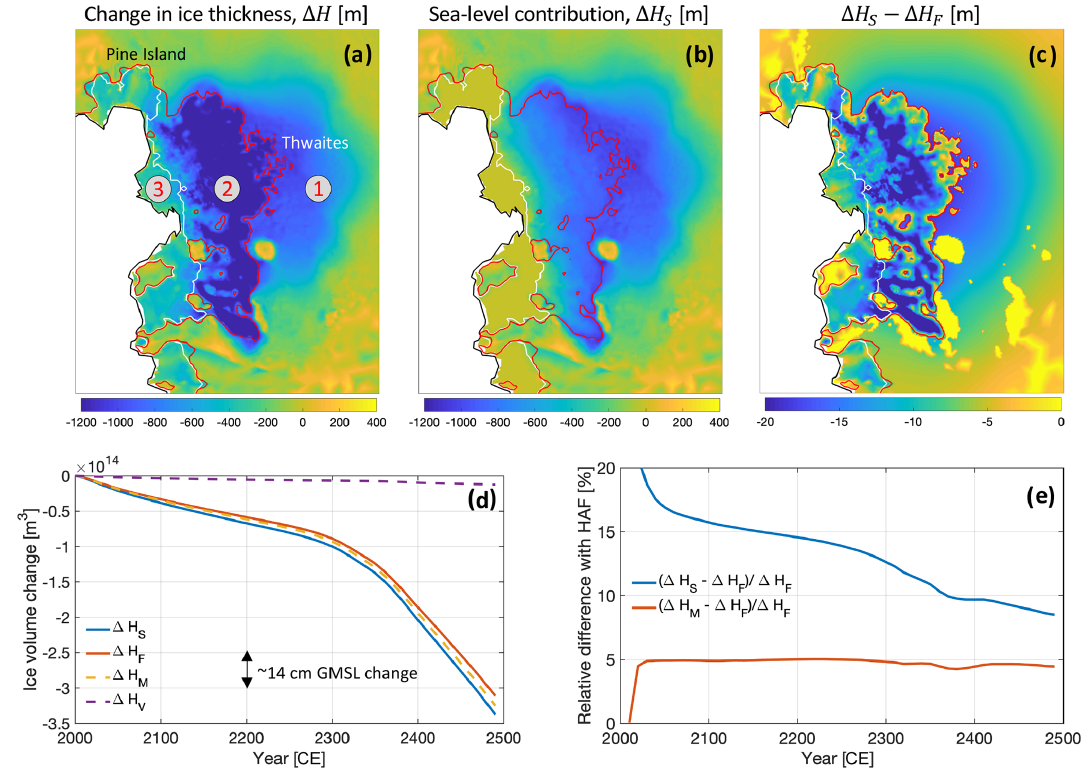
Figure 3. Example of ice-thickness change and its contribution to the sea level. (a) Modeled change in ice thickness at 2350CE for portions of Pine Island and Thwaites glaciers adjacent to the Amundsen Sea (Larour et al., 2019). The black line denotes the ice–ocean interface at 2000CE and the white (red) line denotes the land–ocean interface, i.e., grounding lines, at 2000CE (2350CE). These interfaces are used to separate three regimes of the ice sheet as defined in Sect. 3 (see also Fig. 2b). (b) Estimation of ice thickness that contributes to the sea level over the next 350 years based on the new method proposed in this study (Eq. 10). (c) Comparison of our method with respect to the HAF method (Eq. 9). Note that only in portions of Regime 1 where the bedrock elevation is higher than the MSL do the two methods agree (yellow patches). (d) The total volume change of the Antarctic Ice Sheet that is attributable to the sea-level change. While (cid:49)H M and (cid:49)H F modulate both the mass and volume of the ocean, (cid:49)H V only modulates the ocean volume. (e) Difference between the new method and the HAF method. The latter method underpredicts the sea-level contribution of the ice sheet throughout the model simulation. The mass component of the new method alone consistently predicts 5% more sea-level contribution than the HAF